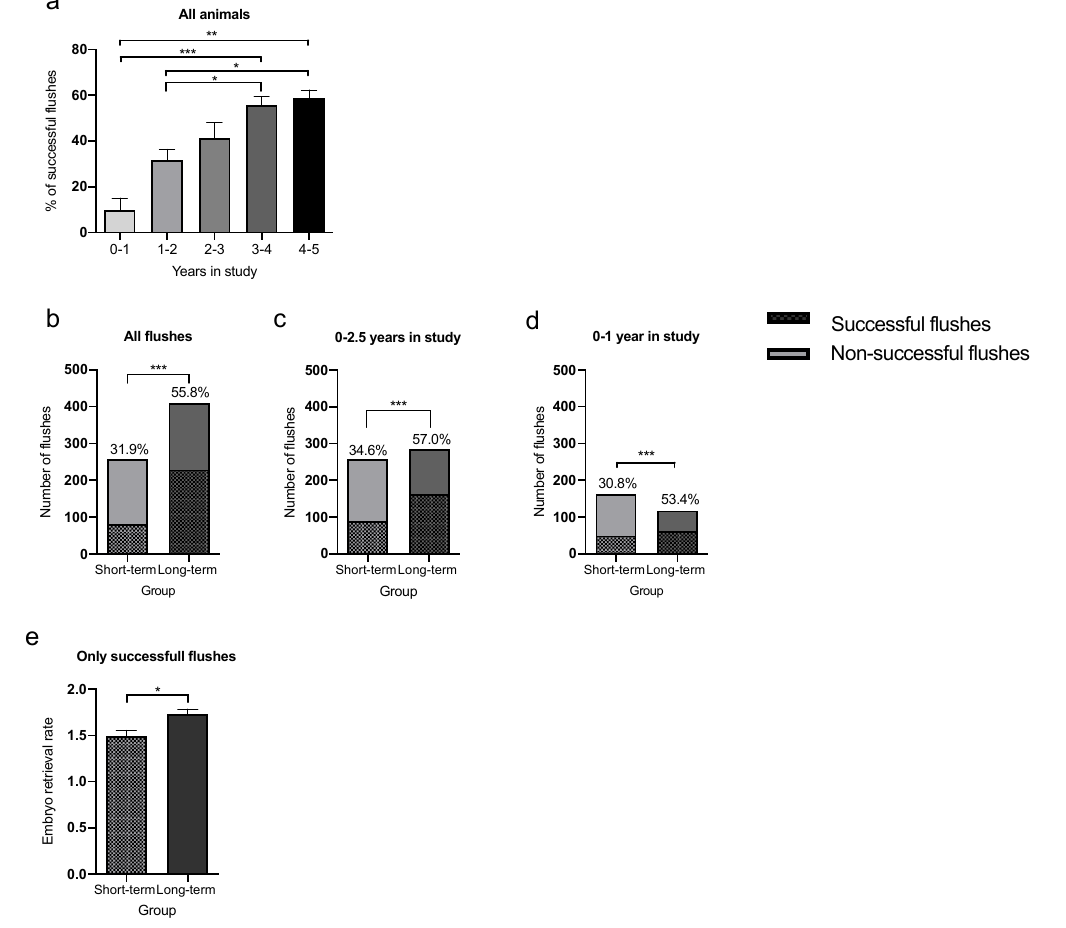
Figure 3. Differentiation between successful and unsuccessful flushes for embryo retrieval in female marmosets ( n = 32). ( a ) Female marmosets show an increase in the percentage of successful flushes, that yielded at least one embryo. Animals in the LTG had a higher embryo flush success rate, with more than 50% of all flushes being successful ( b ) over the whole study period ( p < 0.0001), ( c ) during the first 2.5 years within the study ( p < 0.0001), and ( d ) during the first year of experiments ( p = 0.0002). ( e )When evaluating only the successful flushes, the ERR was higher in animals in the LTG ( p = 0.0442) ( n = 229 flushes) compared to animals in the STG ( n = 81 flushes). Bars represent mean ± SEM. * p < 0.05; ** p < 0.01; *** p < 0.001.